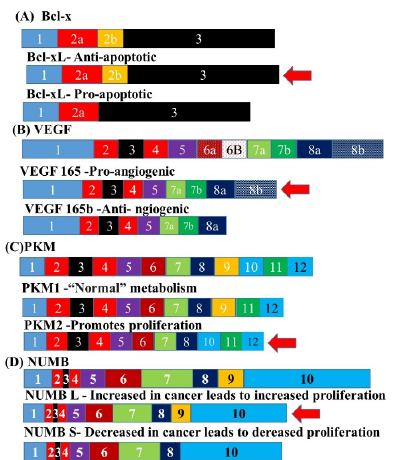
Figure 5. The role of alternative splicing of specific genes in tumorigenesis. The diagram illustrates the roles of different isoforms of Bcl [96] ( A ), VEGF [97] ( B ), PKM [96] ( C ) and NUMB [98] ( D ) in specific hallmarks of cancer such as resistance to apoptosis (Bcl), uncontrolled proliferation (NUMB), a metabolic shift to glycolysis (PKM) and increased angiogenesis (VEGF). The red arrows indicate the isoforms that are found to be expressed at higher levels in OSCC. The same exons in the same genes are shown by identical colors. Table 4. Splice variants involved in OSCC.